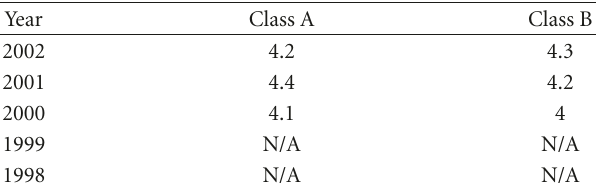
Figure 9: Complete image catching and processing system.